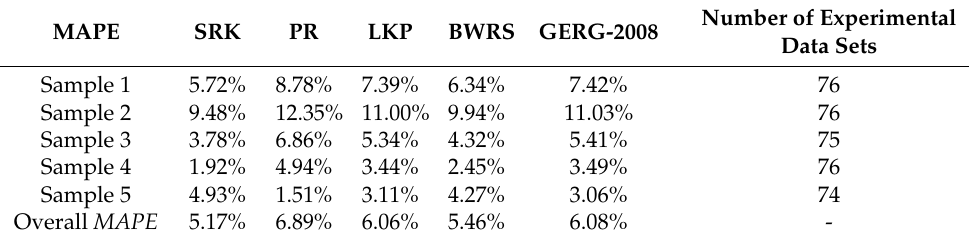
Table 7. MAPE s of experimental and calculated results in the compressibility factor